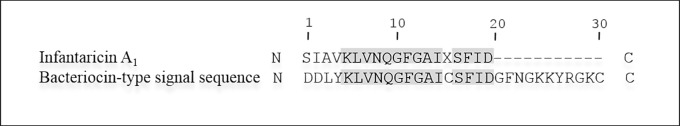
Alignment of the partial N-terminal sequence of infantaricin A1 and the bacteriocin-type signal sequence from S. infantarius subsp. infantarius ATCCBAA-102.Identical residues are shaded in grey. “X” indicates an unidentified residue.